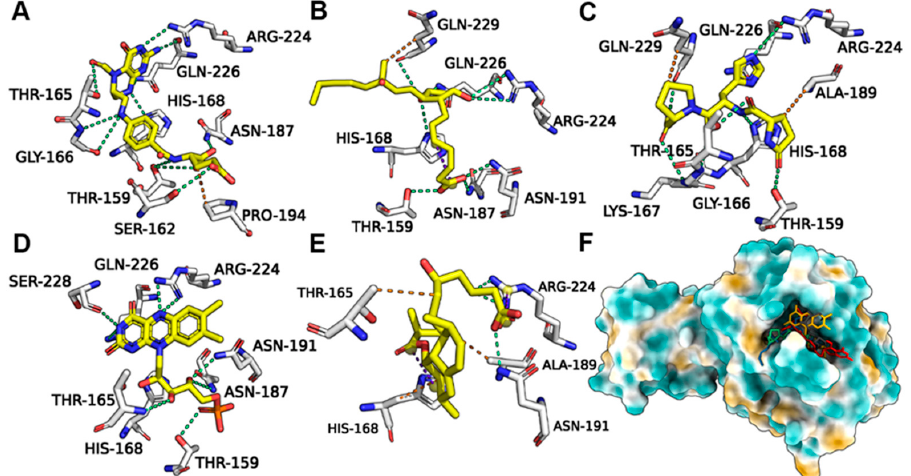
Figure 5. Binding conformations of FDA ‐ approved drugs with ASFV pS273R. ( A ) Leucovorin with Crystal (6LJ9A). ( B ) Carboprost with Crystal (6LJ9A). ( C ) Protirelin with Crystal (6LJ9A). ( D ) Flavin Mononucleotide with Crystal (6LJ9A). ( E ) Lovastatin Acid with Crystal (6LJ9A). ( F ) Positions of the five candidate molecules in the Crystal (6LJ9A) active pocket. Table 1. Watvina docking scores of FDA ‐ approved drugs with Crystal (6LJ9A), Cluster 1, and Clus ‐ ter 2.